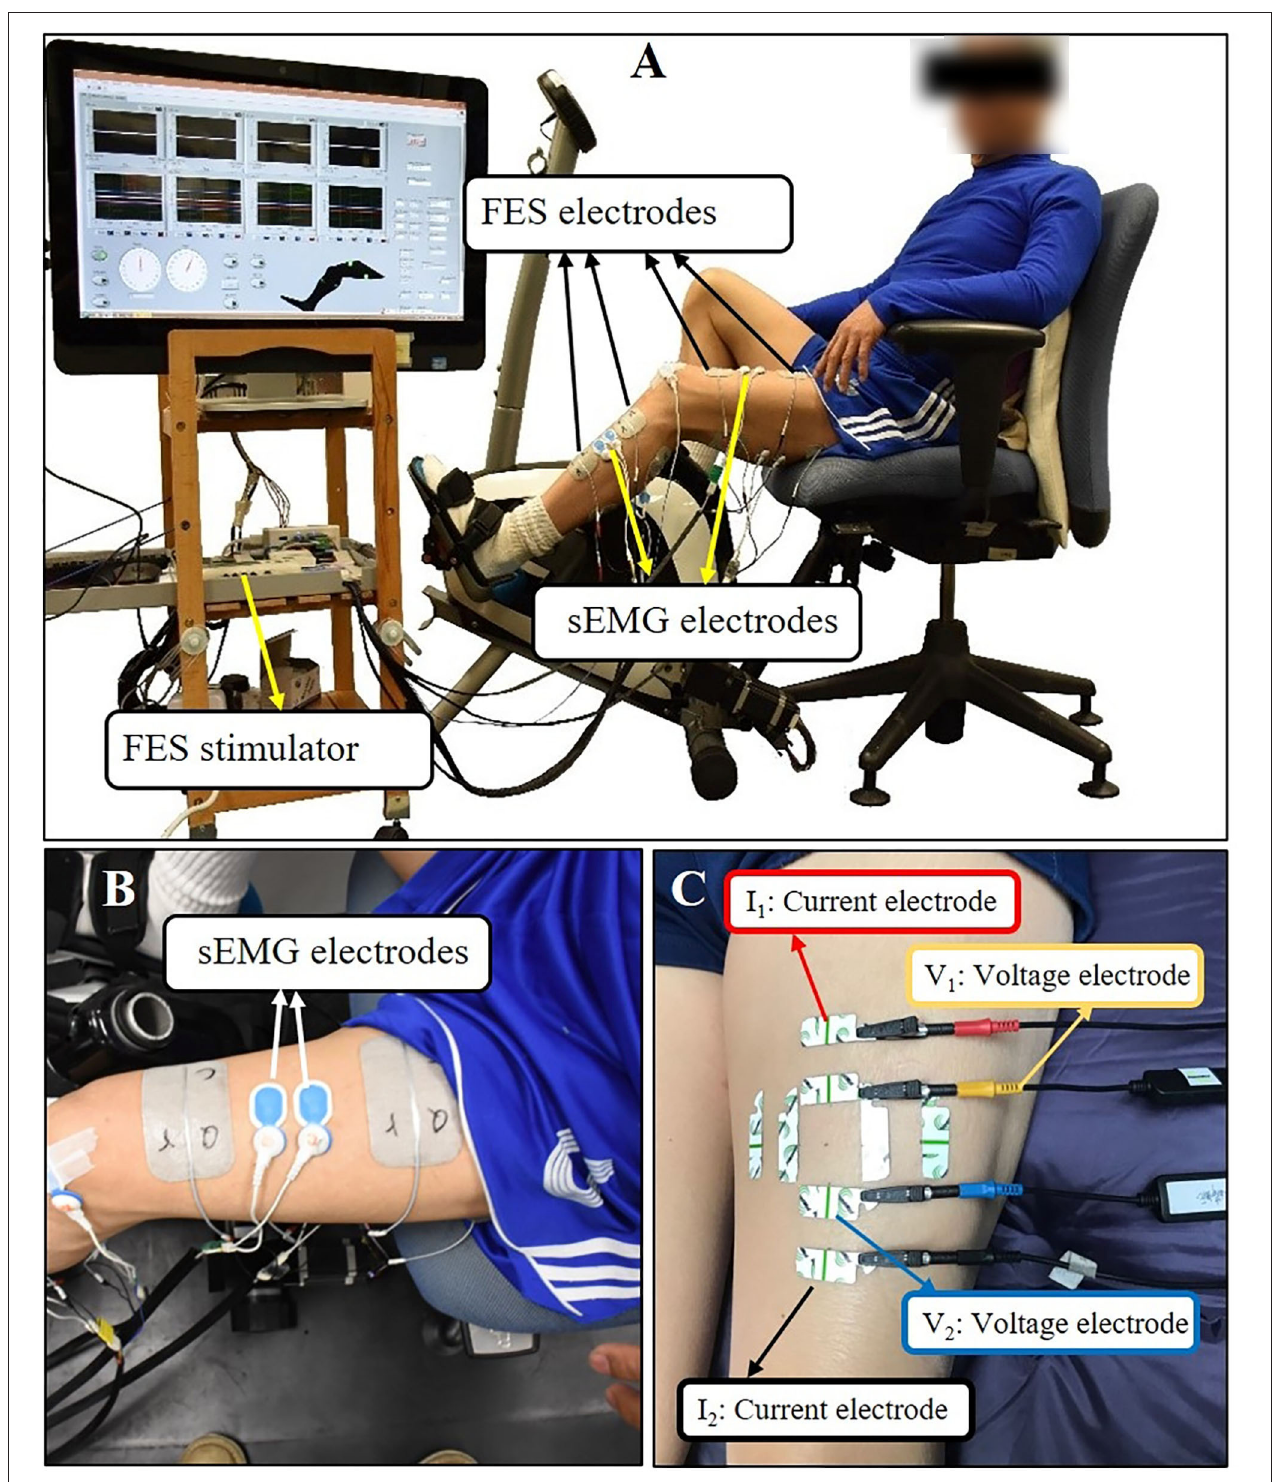
FIGURE 1 | (A) The setup of FES-assisted cycling training system. The pedaling angle was monitored by a goniometer. (B) Using quadriceps as an example for sEMG electrodes placement. (C) Using quadriceps as an example for EIM electrodes placement. The outer two electrodes (the red and black one) were current electrodes, inner two electrodes (the yellow and blue one) were voltage electrodes. Each test lasted for few seconds and three tests were conducted repeatedly at each direction of the arrangement.